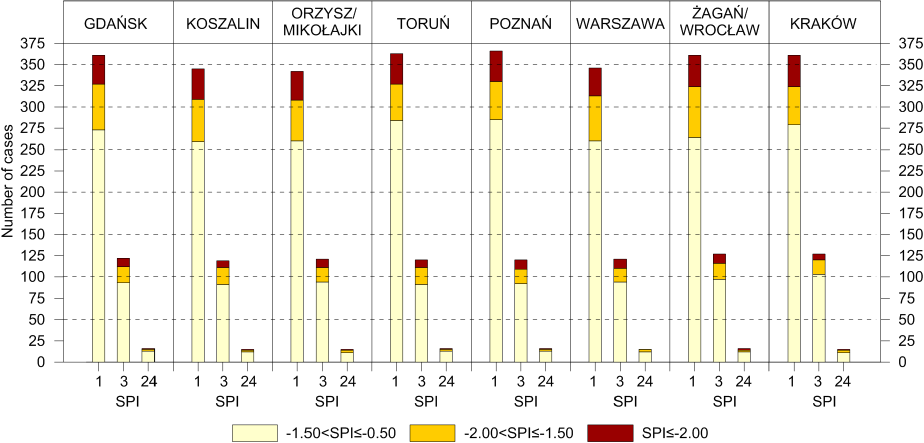
Figure 12. Frequencies of dry months (SPI1), short-term droughts (SPI3), and long-term droughts (SPI24) in Poland, including three intensity categories calculated using Łab˛edzki’s